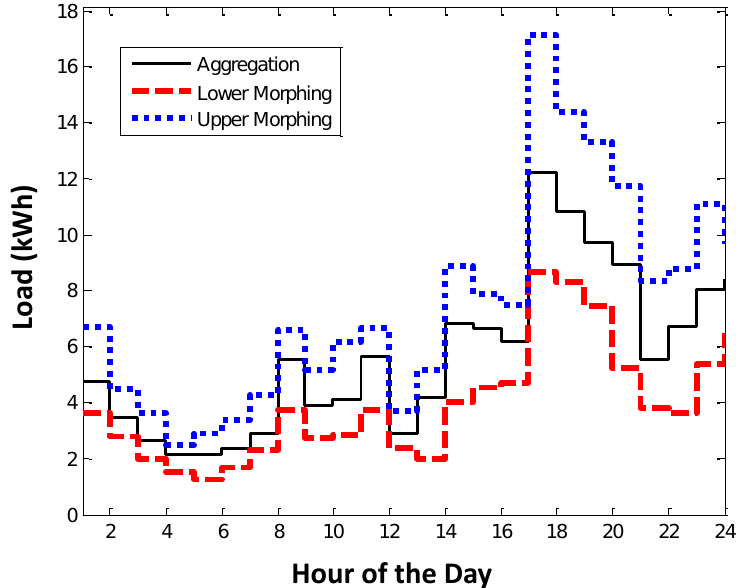
Figure 7. Aggregated load pattern of consumers 1–6 and the respective morphing upper and lower bounds.